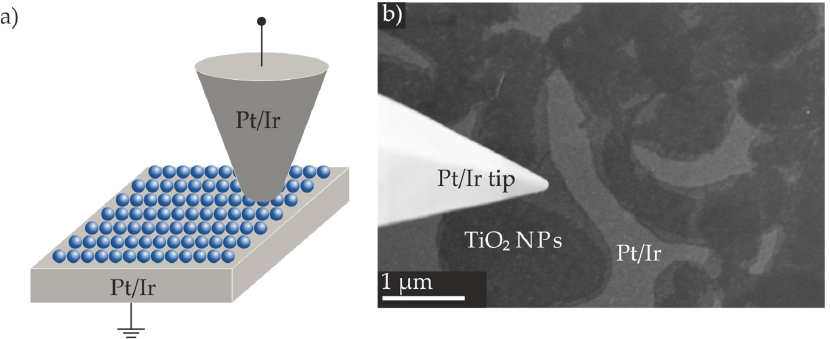
Figure 5. Schematic illustrations of the (Pt/Ir)/TiO 2 NP film/(Pt/Ir tip) device ( a ). Exemplary SEM image of a TiO 2 NP film on the Pt/Ir surface transferred by the one-step method; on the left hand side, the Pt/Ir coated tip electrode is visible ( b ) (contrast of the SEM image was increased after the measurement; for the original SEM image, see Figure S4).